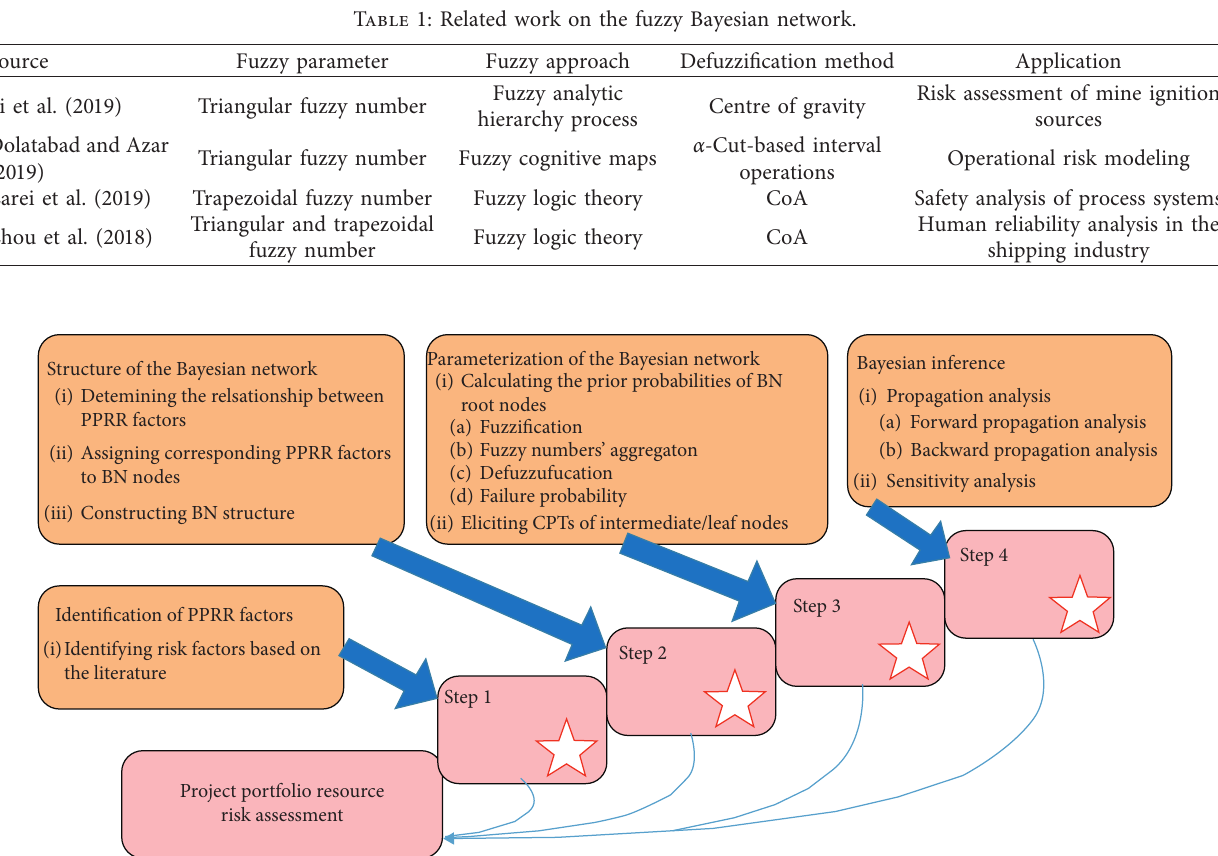
Figure 1: The workflow of project portfolio resource risk